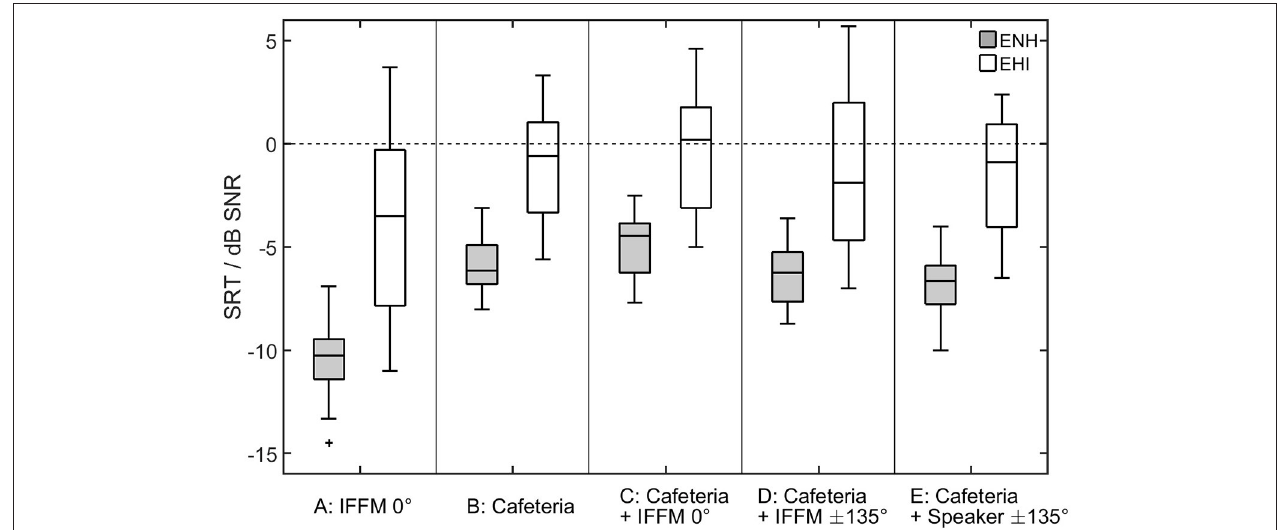
FIGURE 3 | SRTs obtained by the ENH and the EHI group for the five listening conditions (A–E) shown in Figure 2. The horizontal line in each box indicates the median, and the boxes indicate the 25th and 75th percentiles,